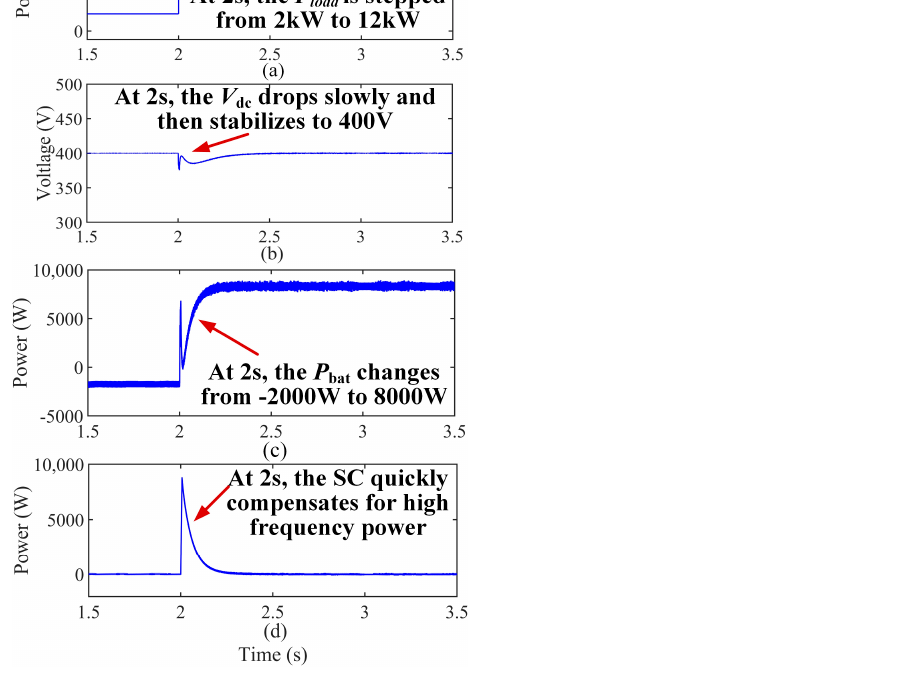
Figure 12. Simulation results when control parameters of Group A are used. ( a ) CPL power, ( b ) DC bus voltage, ( c ) battery power and ( d ) SC power. bus voltage, ( c ) battery power and ( d ) SC power.